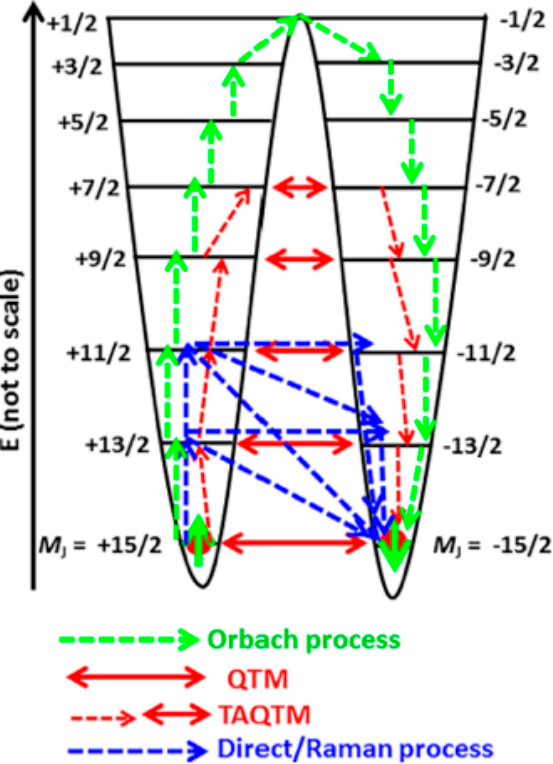
Figure 2. All possible magnetic relaxation processes involved in single-molecule magnets (SMMs).